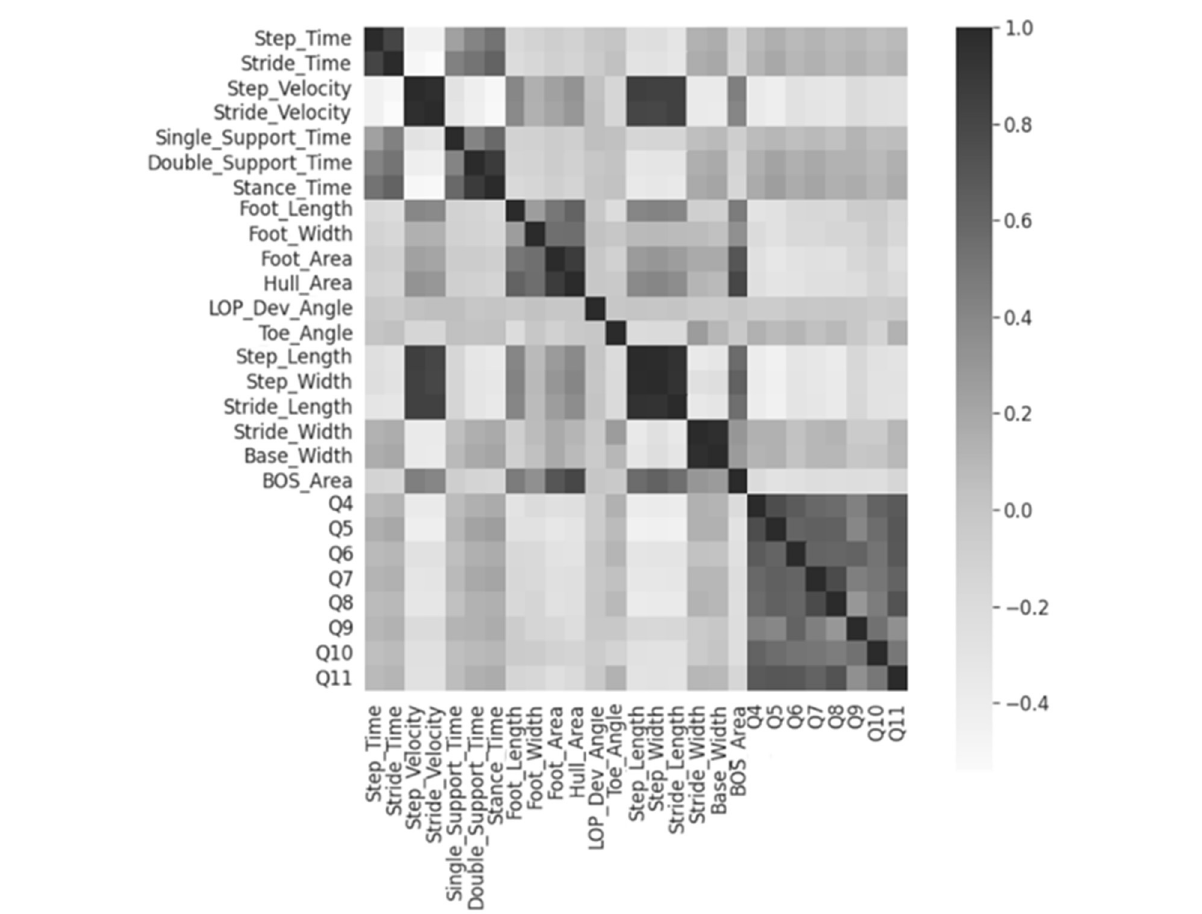
FIGURE2 Heatmap for numerical feature correlations. Heatmap regions that are increasingly dark show areas of higher correlations. Q4-Q11 represents the MSIS-29 questions 4 to